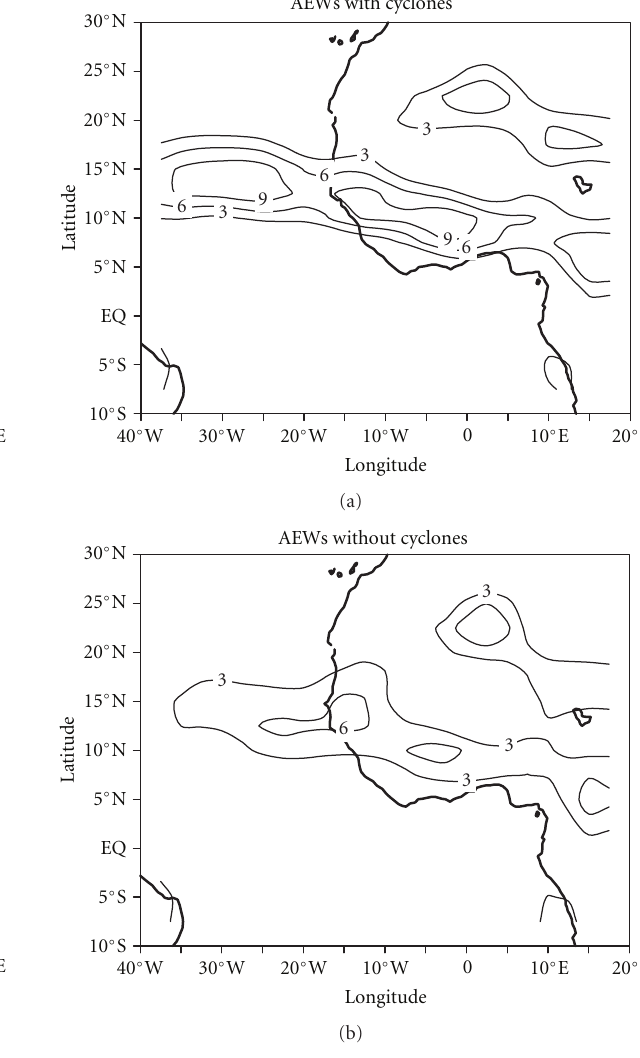
Figure 5: Horizontal shear of zonal wind at 700hPa for AEWs associated with cyclones (a) and for non-developing AEWs (b). Unit is 10 − 6 s − 1 .